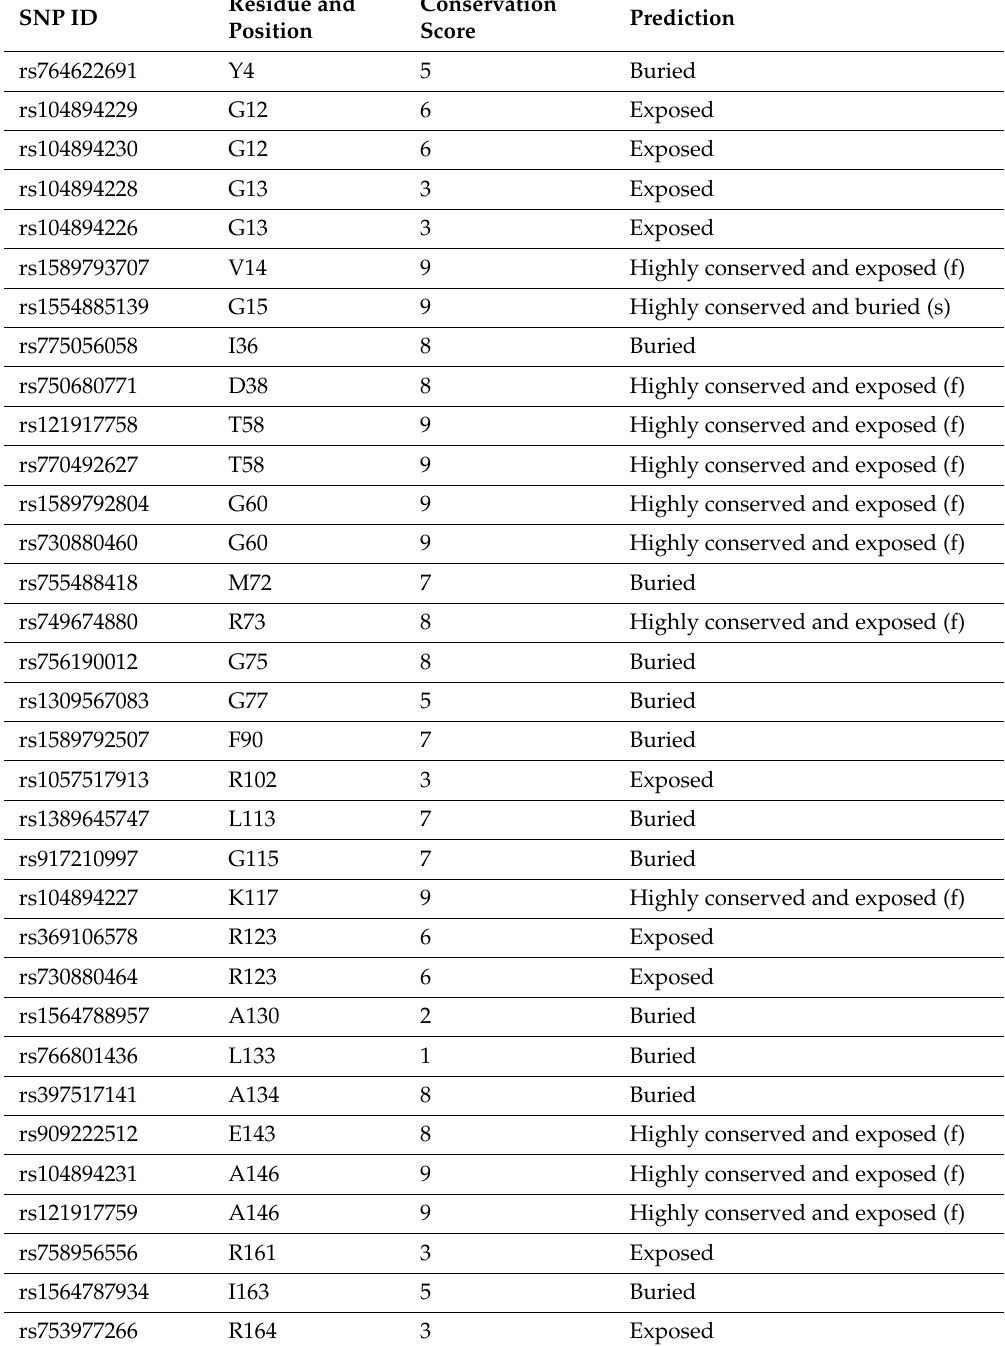
Table 3. ConSurf predictions showing conservation profile of amino acids in